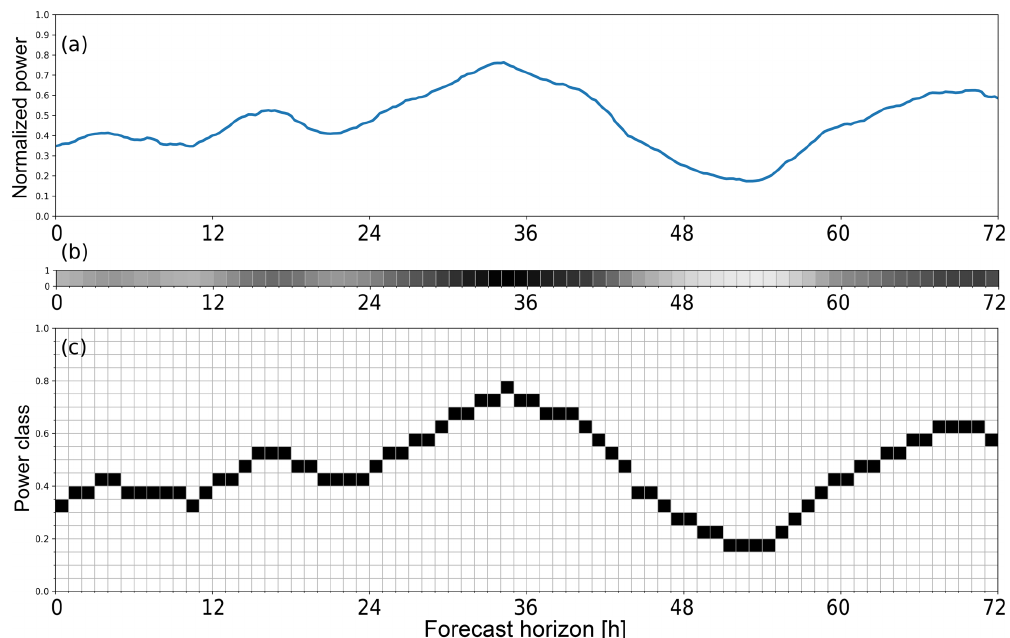
Figure 1. (a) Targets ( = observations) belonging to one forecast run. (b) Conventional encoding: one continuously valued out-put neuron per forecast horizon. (c) Probabilistic encoding: 20 output neurons per forecast horizon. The one representing the correct power class is set to unity, the others to zero.